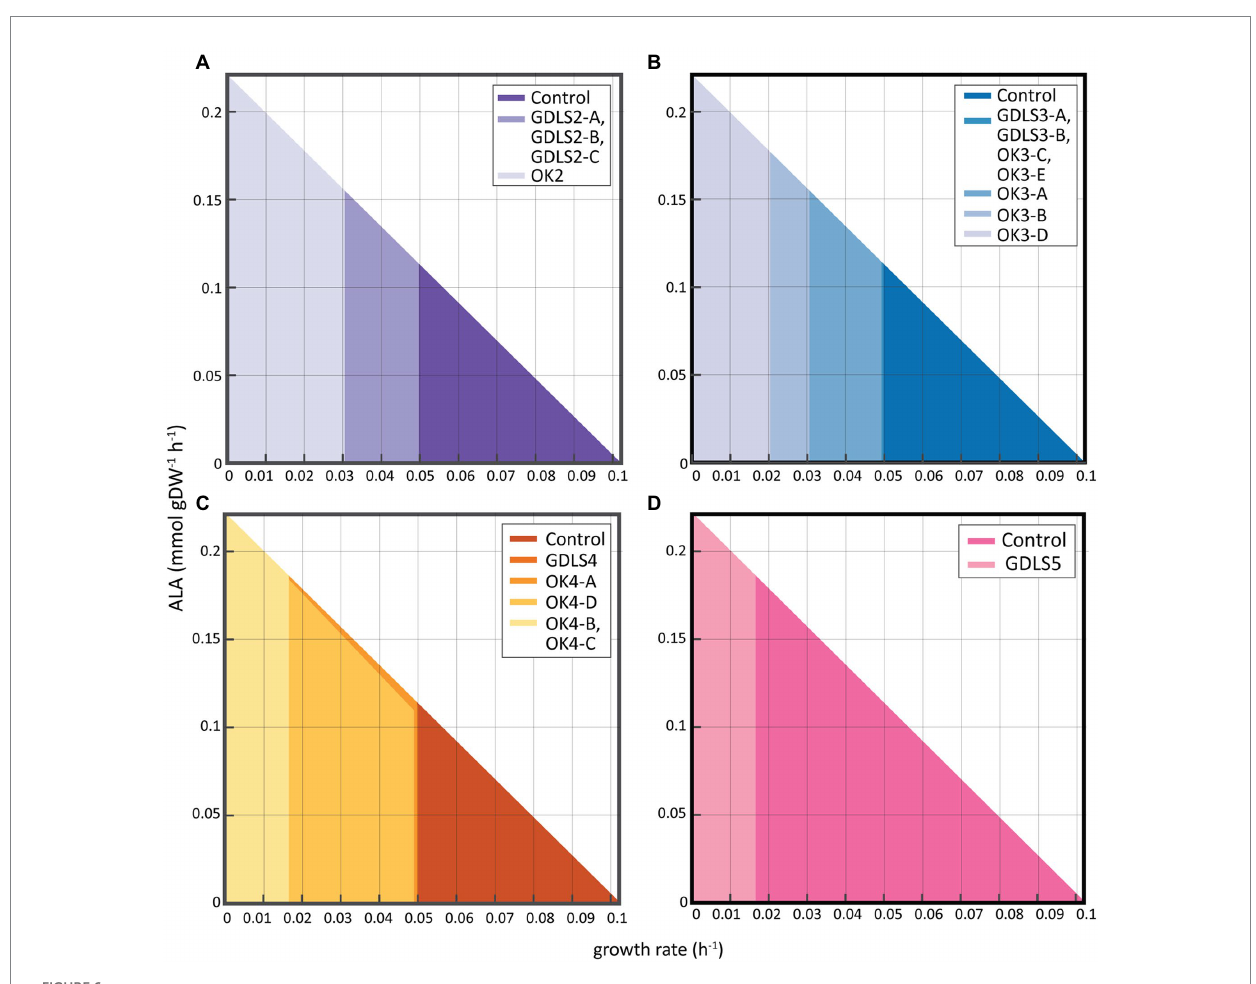
FIGURE 6 Production envelope for S. elongatus PCC 7942 mutants with enhanced ALA production obtained with GDLS and OptKnock. Maximum optimal production rate (mmol gDW − 1 h − 1 ) of ALA achievable with (A) two knockouts; (B) three knockouts; (C) four knockouts; and (D) five